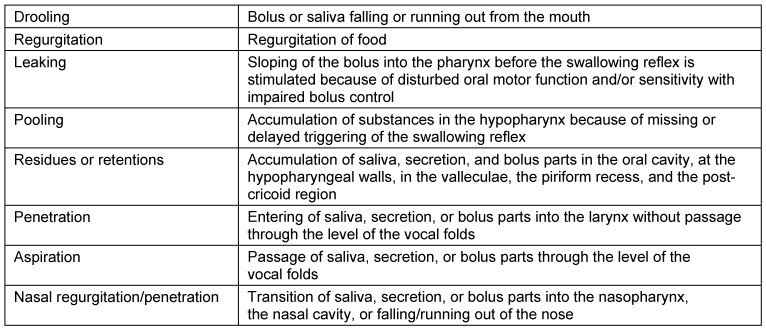
Overview of the nomenclature regarding symptoms of swallowing disorders